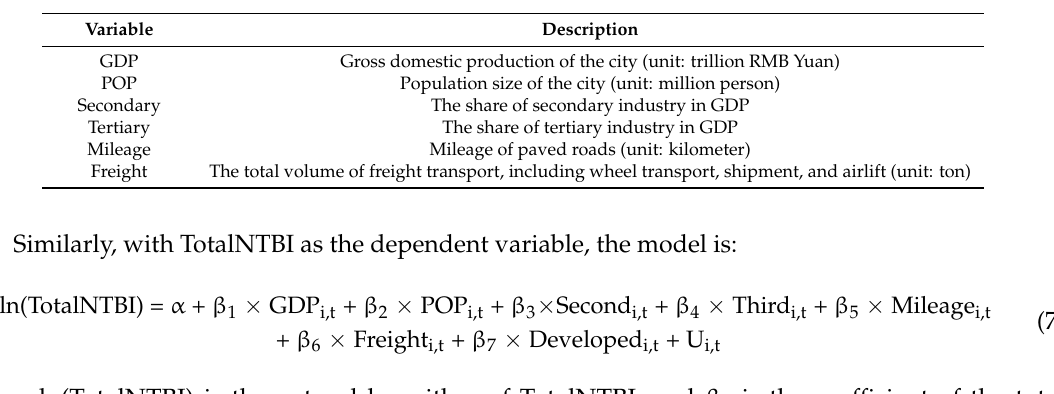
Table 2. Description of socioeconomic variables